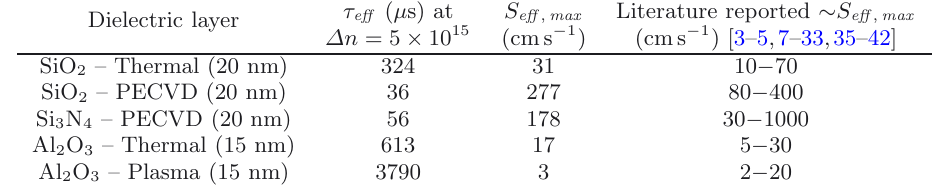
Table 3. Extracted τ eff , S eff , max values from lifetime measurements at an injection point Δn = 5 × 10 15 cm − 3